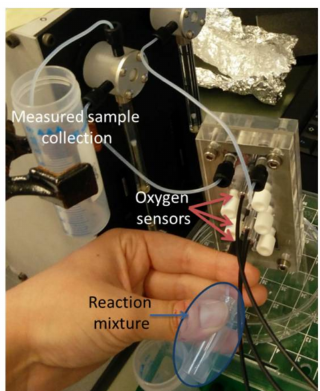
Figure 4. Oxygen measurement setup used for screening variants for styrene biotransformation: pulling approach, with the oxygen sensors position indicated.